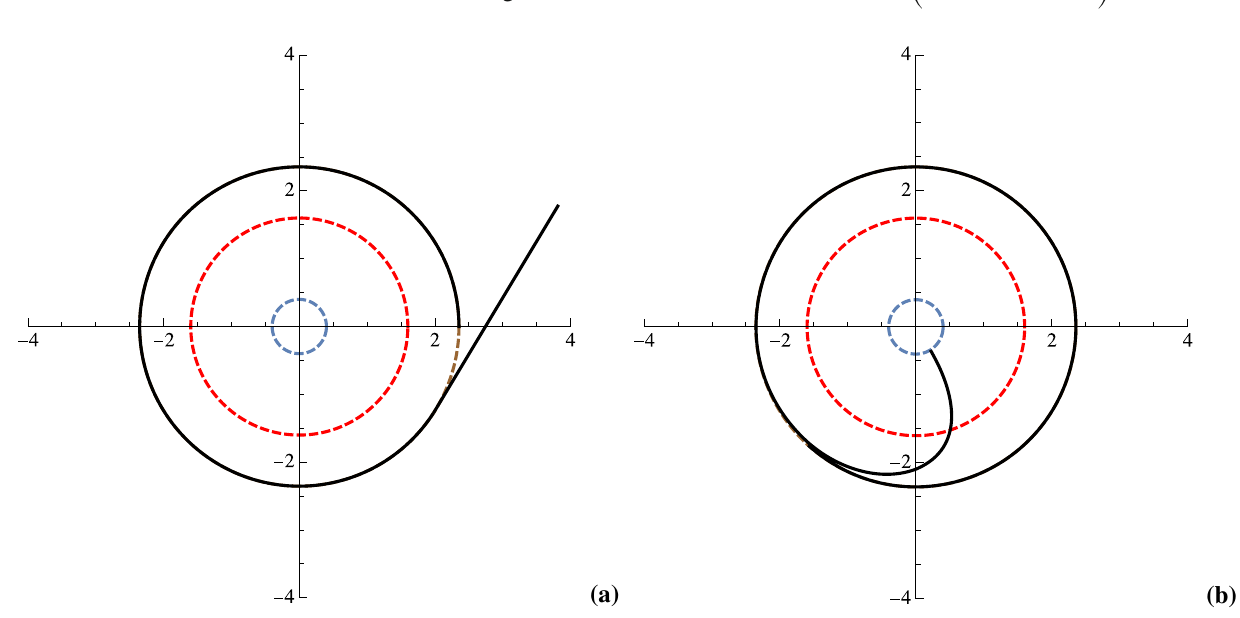
Fig. 5 The polar plots of (a) the UCOFK and (b) the UCOSK, plotted for ω 0 ≈ ω U . The outer circle, indicates r U ≈ 2 .